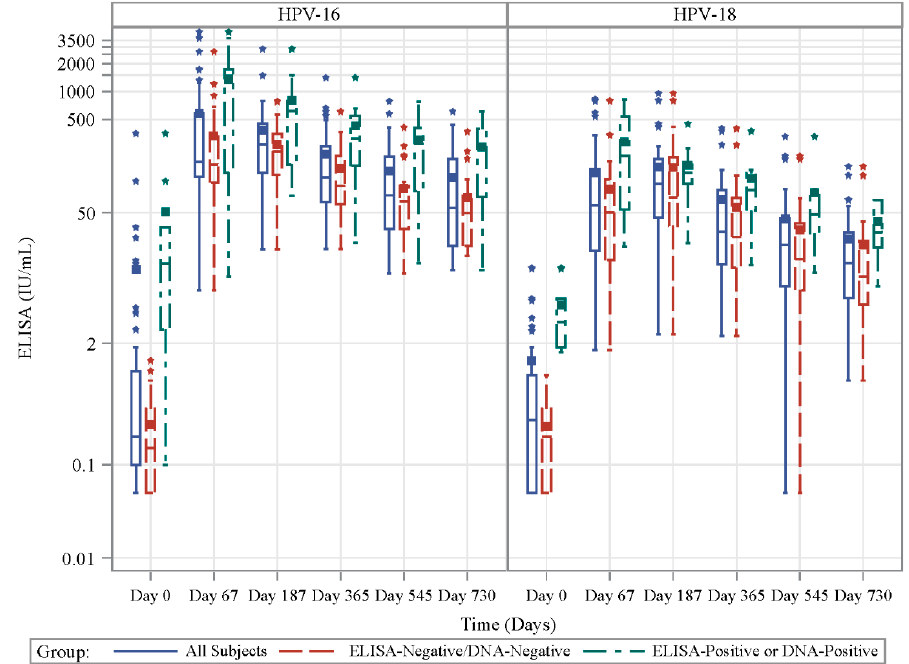
Figure 3. Antibody levels measured by ELISA increased in response to HPV vaccination. HPV-16- (left side) specific and HPV-18-(right side) specific antibody (Ab) titers detected by ELISA (IU/mL) at Days 0, 67, 187, 365, 545 and 730 in prospective cohort for all (solid blue line), HPV-naïve (dashed red line) and HPV-exposed(dashed green line) subjects.